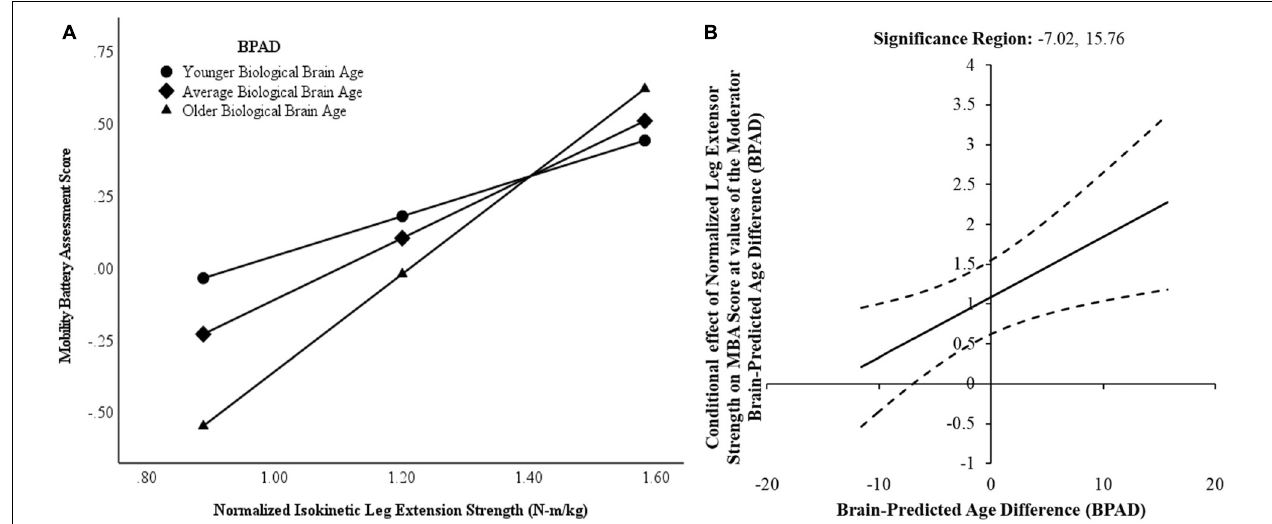
FIGURE 4 | Conditional effects of brain-predicted age difference (BPAD) on the strength-function relationship. (A) Normalized leg extensor strength and composite mobility battery assessment (MBA) score demonstrate a weaker relationship for low (younger) brain age (16th percentile). In contrast, normalized leg extensor strength is a stronger predictor of MBA score for average and high (older) brain age (84th percentile). (B) Johnson–Neyman plot indicating conditional effects of brain-predicted age difference (BPAD) on the relationship between leg extensor strength and mobility battery assessment (MBA) score performance with a 95% confidence interval (dashed line). Note the vertical boundary lines indicate the range of BPAD where normalized leg extensor strength is a significant predictor of MBA